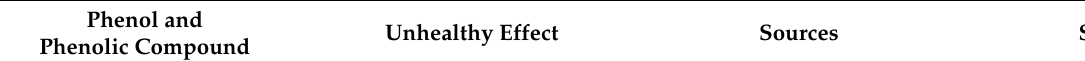
Table 4. Structure, sources, and toxic effects of phenol and phenolic compounds.